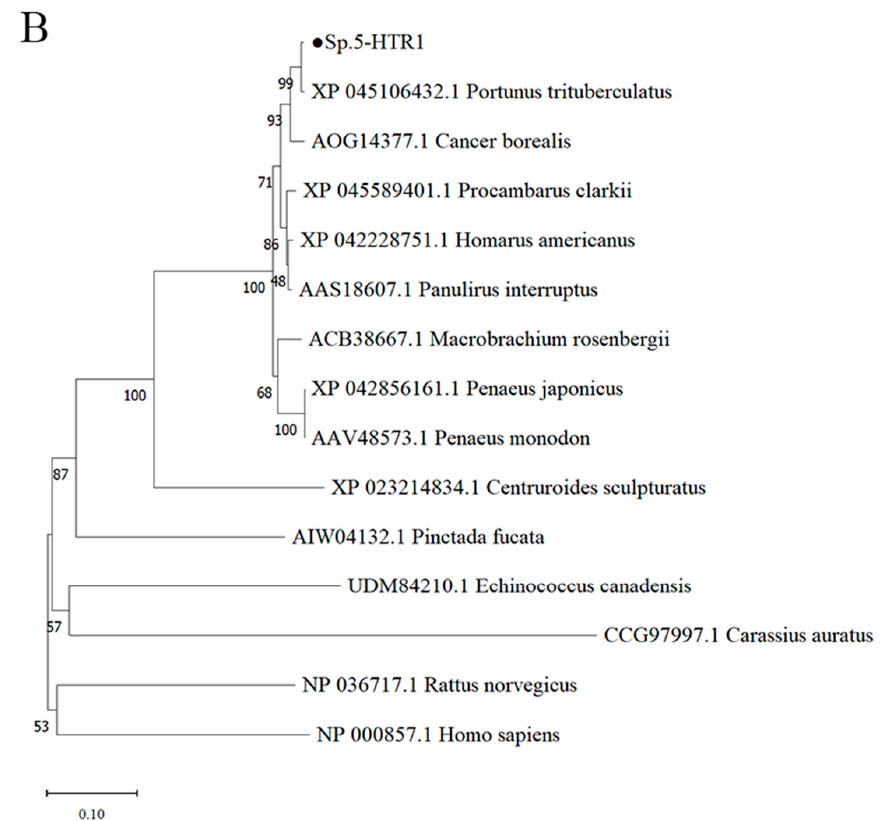
Figure 2. ( A ) Multiple sequence alignment and ( B ) phylogenetic tree of CRD in Sp5–HTR1 and other 5–HTRs . The conserved amino acid residues are shaded in black. Sequences: 5–hydroxytryptamine